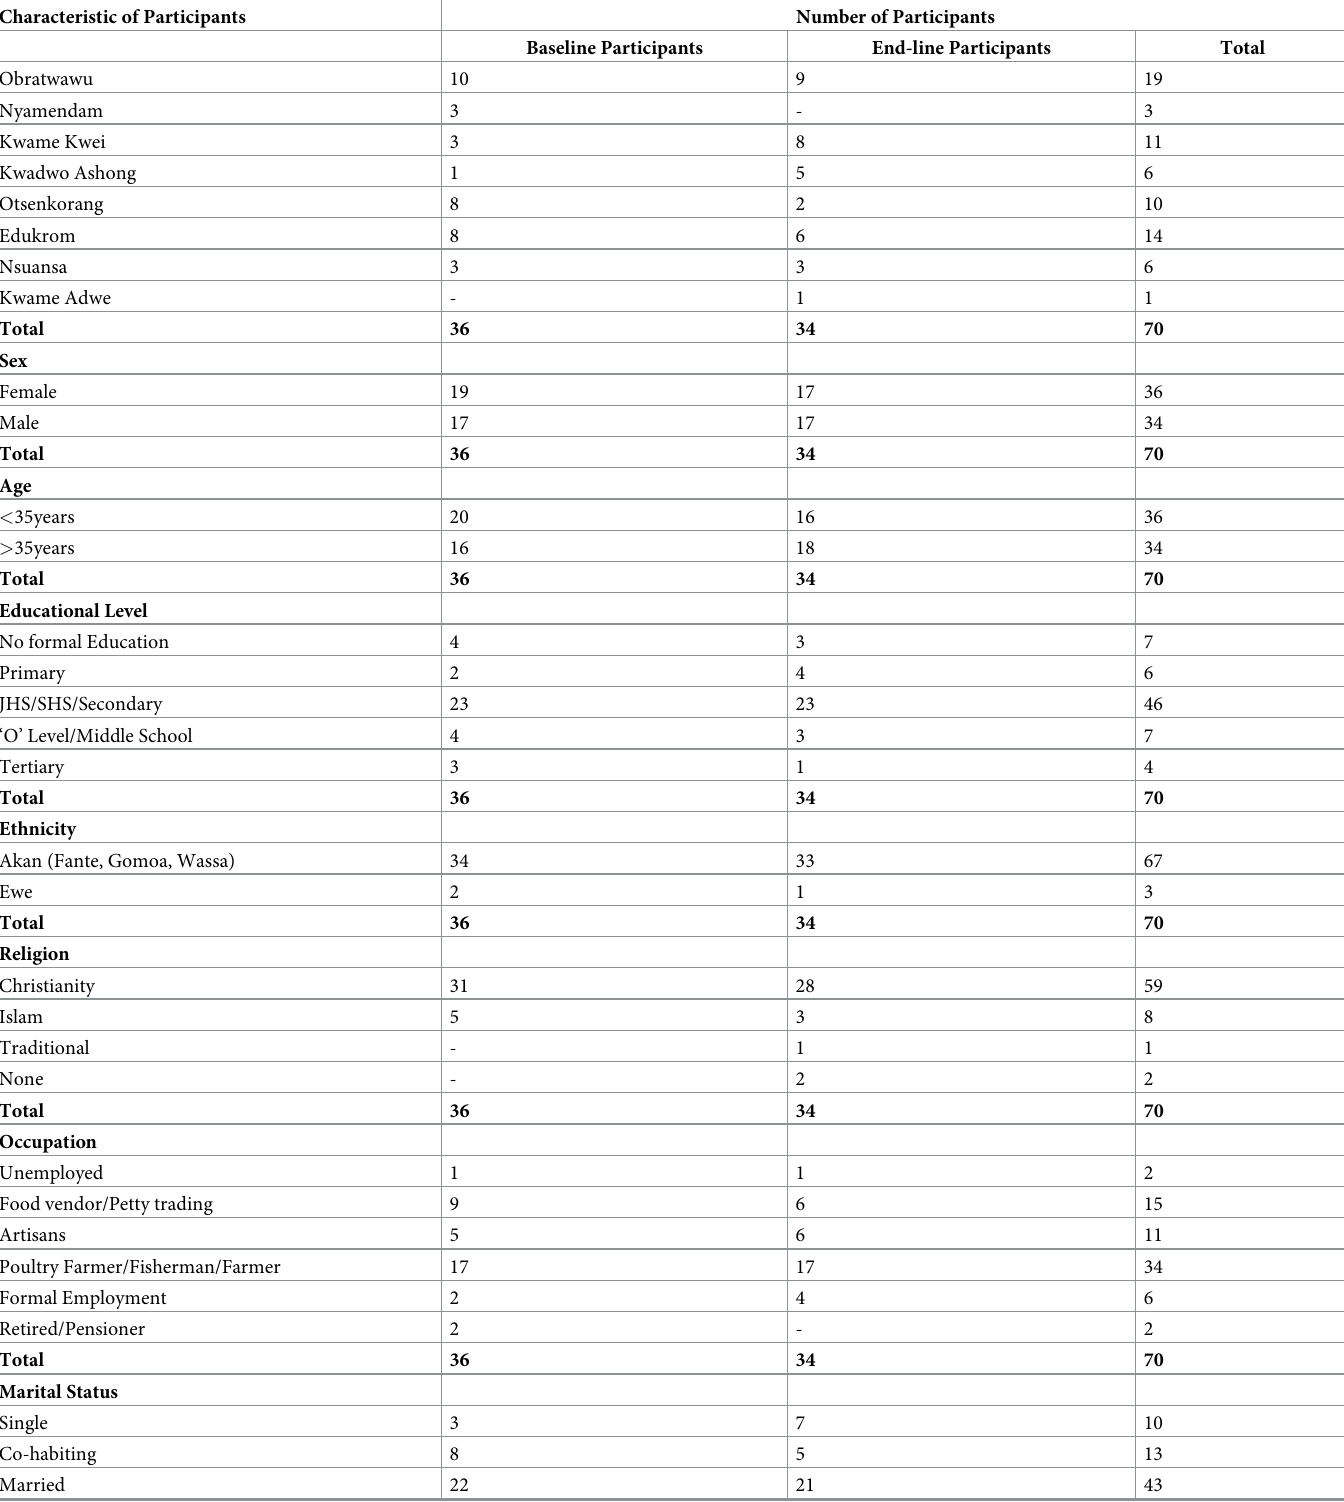
Table 1. Socio-demographic characteristics of baseline and end-line